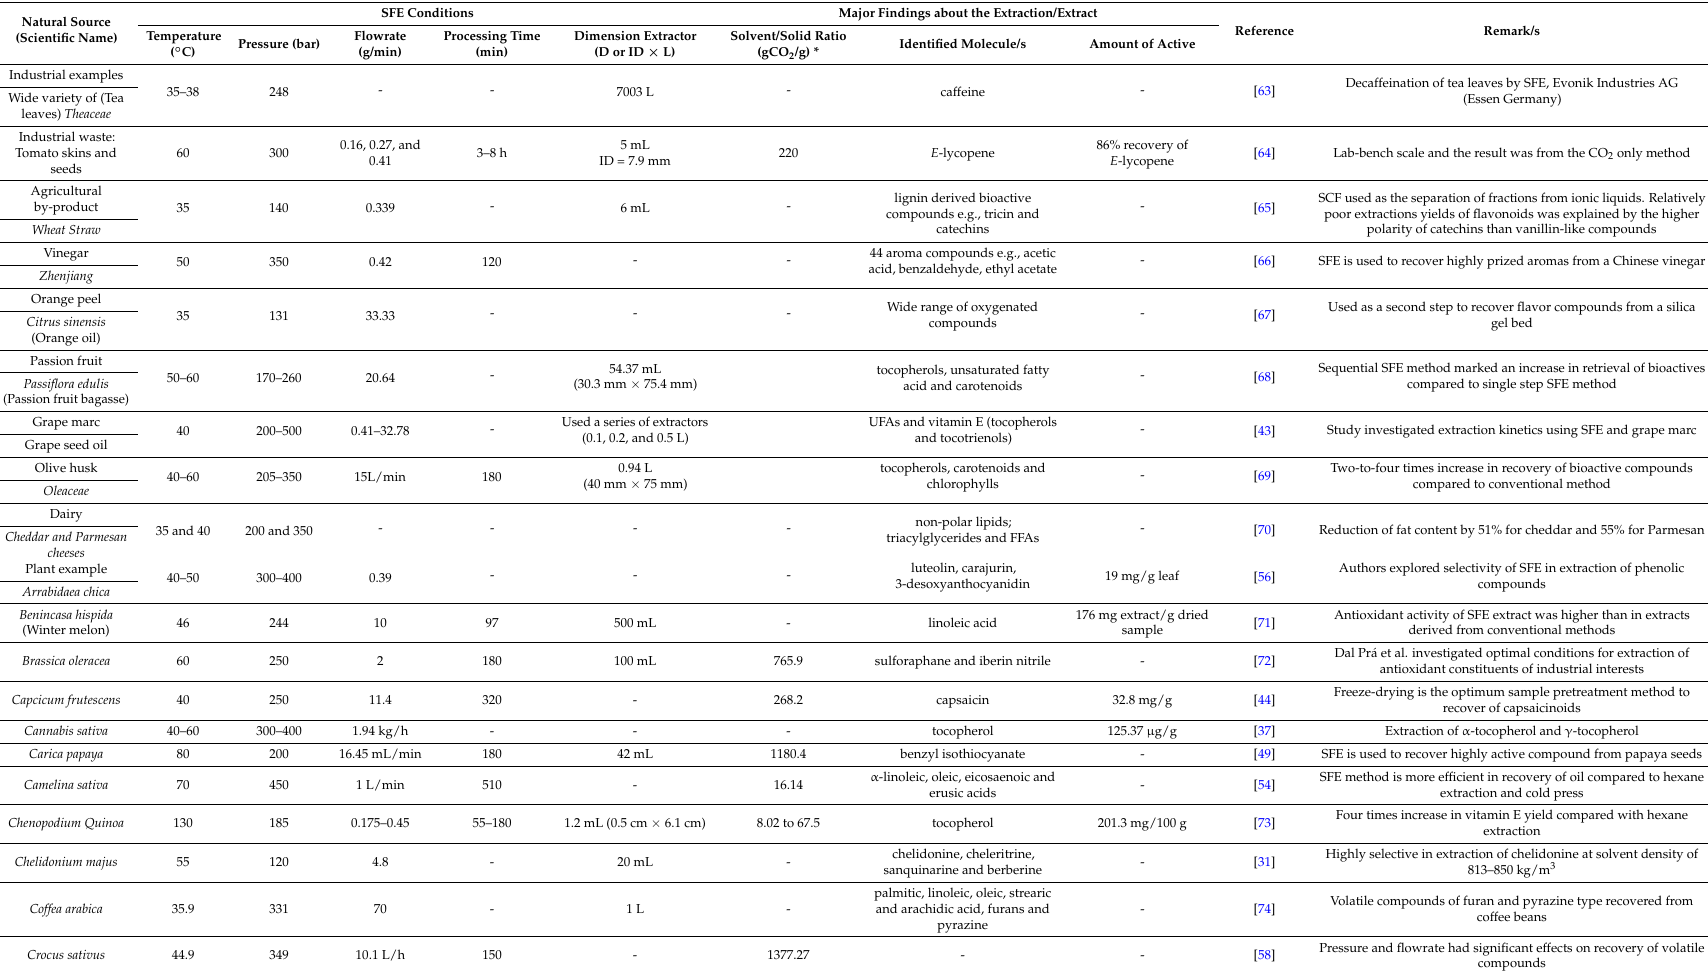
Table 4. Solvent supercritical fluid extraction of natural